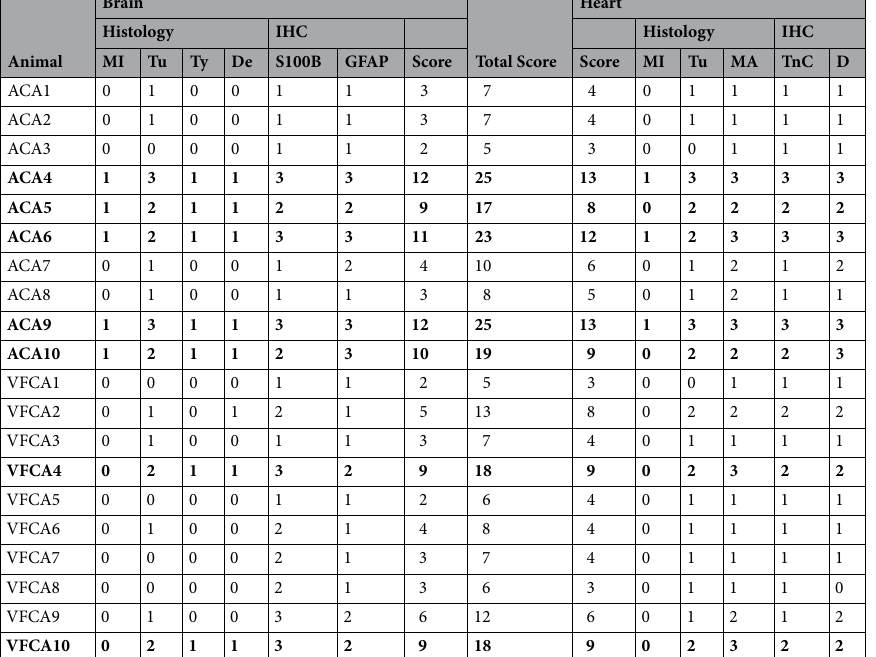
Table 2. Results of histopathological and immunohistochemical analyses of brain and heart samples, with partial and global arbitrary scores. IHC = Immunohistochemistry; MI = Micro-Infarction; Tu = TUNEL; Ty = Tygrolisis; De = Demyelination; MA = Morphological alterations; GFAP = Glial Fibrillary Acid Pro; TnC = C-Troponin; D = Desmin. Assigned scores: MI, Ty, De: 0 = absent, 1 = present; MA, 0 = absent, 1 = mild, 2 = moderate, 3 = severe; Tu: 0 = absent, 1 = up to 2%, 2 = up to 5%, 3 = more than 5%; S100B, GFAP, D, TnC: 0 = absent, 1 = mild, 2 = moderate, 3 =